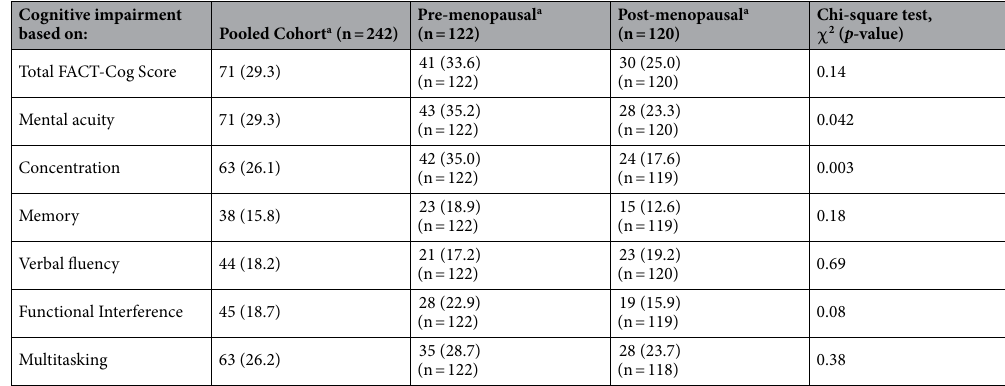
Table 2. Proportion of patients reporting self-perceived cancer-related cognitive impairment (CRCI). a Data are presented as frequency (%) of